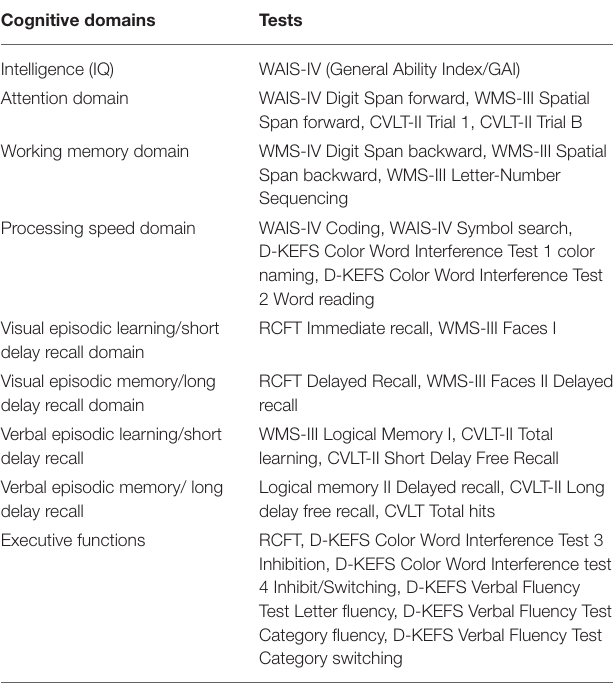
TABLE 2 | Clinical characteristics and cognitive scores in patients with amnestic ( n = 35) and nonamnestic ( n = 16) MCI.